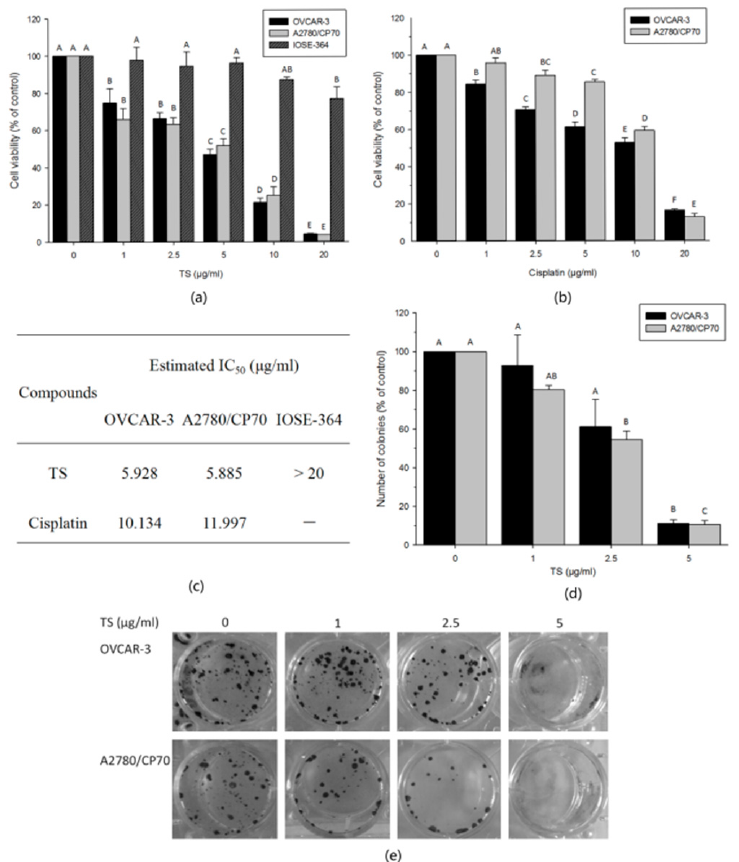
Figure 1. Effects of TS on cell growth and colony formation in vitro in OVCAR-3 and A2780/CP70 human ovarian cancer cells and the cytotoxicity of TS on IOSE-364 normal ovarian cells. ( a ) TS inhibits cell viability of OVCAR-3, A2780/CP70 and IOSE-364 cells after 24 h. Cell viability was determined via MTS assay; ( b ) Cisplatin inhibits cell growth of OVCAR-3 and A2780/CP70 cells after 24 h as a control compared with TS’s inhibitory activity; ( c ) The estimated half-maximal inhibitory concentration (IC 50 ) of TS and cisplatin against ovarian cancer cells and/or normal ovarian cells; ( d ) Colony formation activity of OVCAR-3 and A2780/CP70 cells was inhibited by TS at 24 h; ( e ) TS exhibited extensive colony formation inhibitory effects in OVCAR-3 and A2780/CP70 cells at 24 h. The capital letters (A, B, etc.) mean extremely significant differences among different treatments ( p < 0.01).